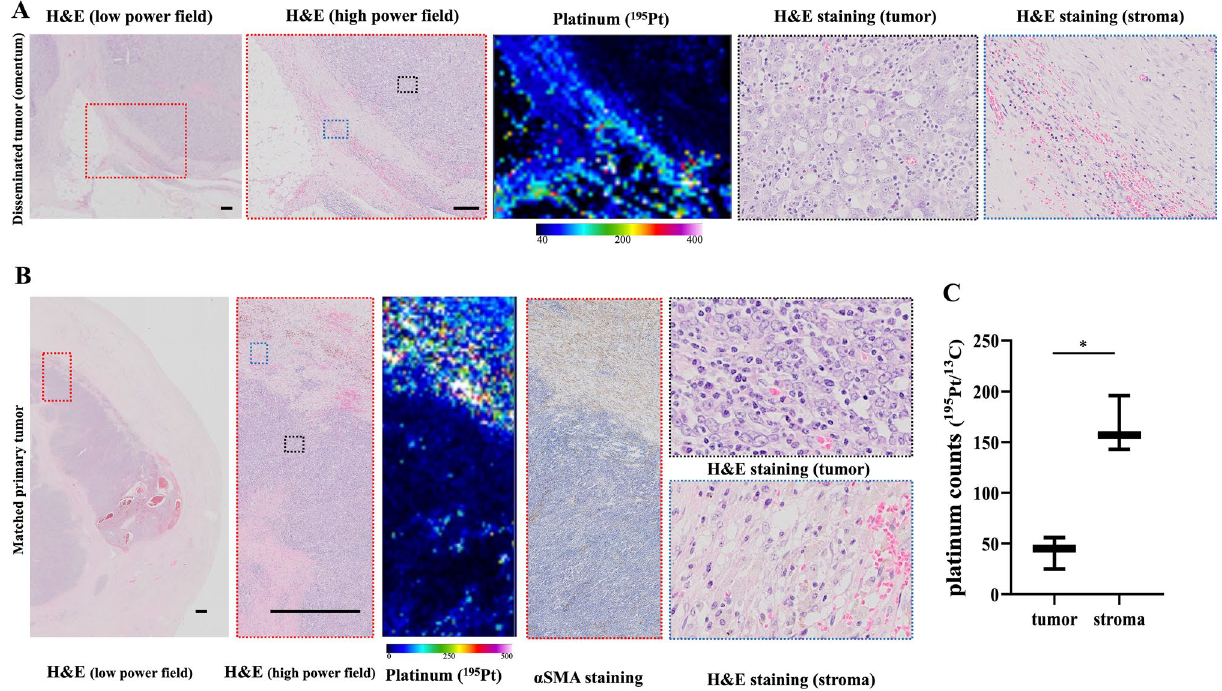
Figure 5. Platinum distribution of the primary tumors and disseminated tumors. ( A ) Representative images of an abdominal dissemination in a type A case. Platinum was accumulated in a marginal area in tumor and stroma and little platinum was present in the tumor. Scale bar: 200 μm. ( B ) The platinum distribution of a matched primary tumor (ovary) of a type A patient. Little platinum existed in the tumor compared to the stroma. Scale bar: 200 μm. ( C ) The platinum counts in the tumor and stroma in disseminated tumors (n =